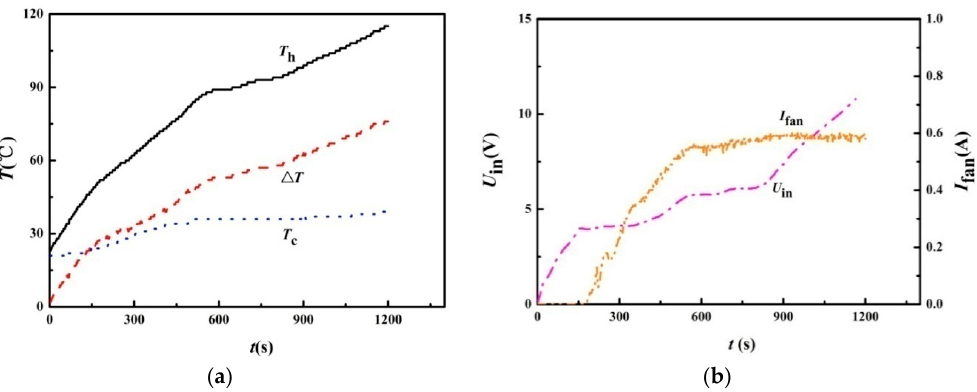
Figure 4. The self-startup process of the STEG. ( a ) The hot end temperature, T h , cold end temperature, T c , and temperature difference, Δ T ; ( b ) the closed circuit input voltage, U in , and the fan current, I fan (Cod1 heat conducting plate, HS1 heat sink, YNJAD the cooling fan and Cof1 the TE module configuration).